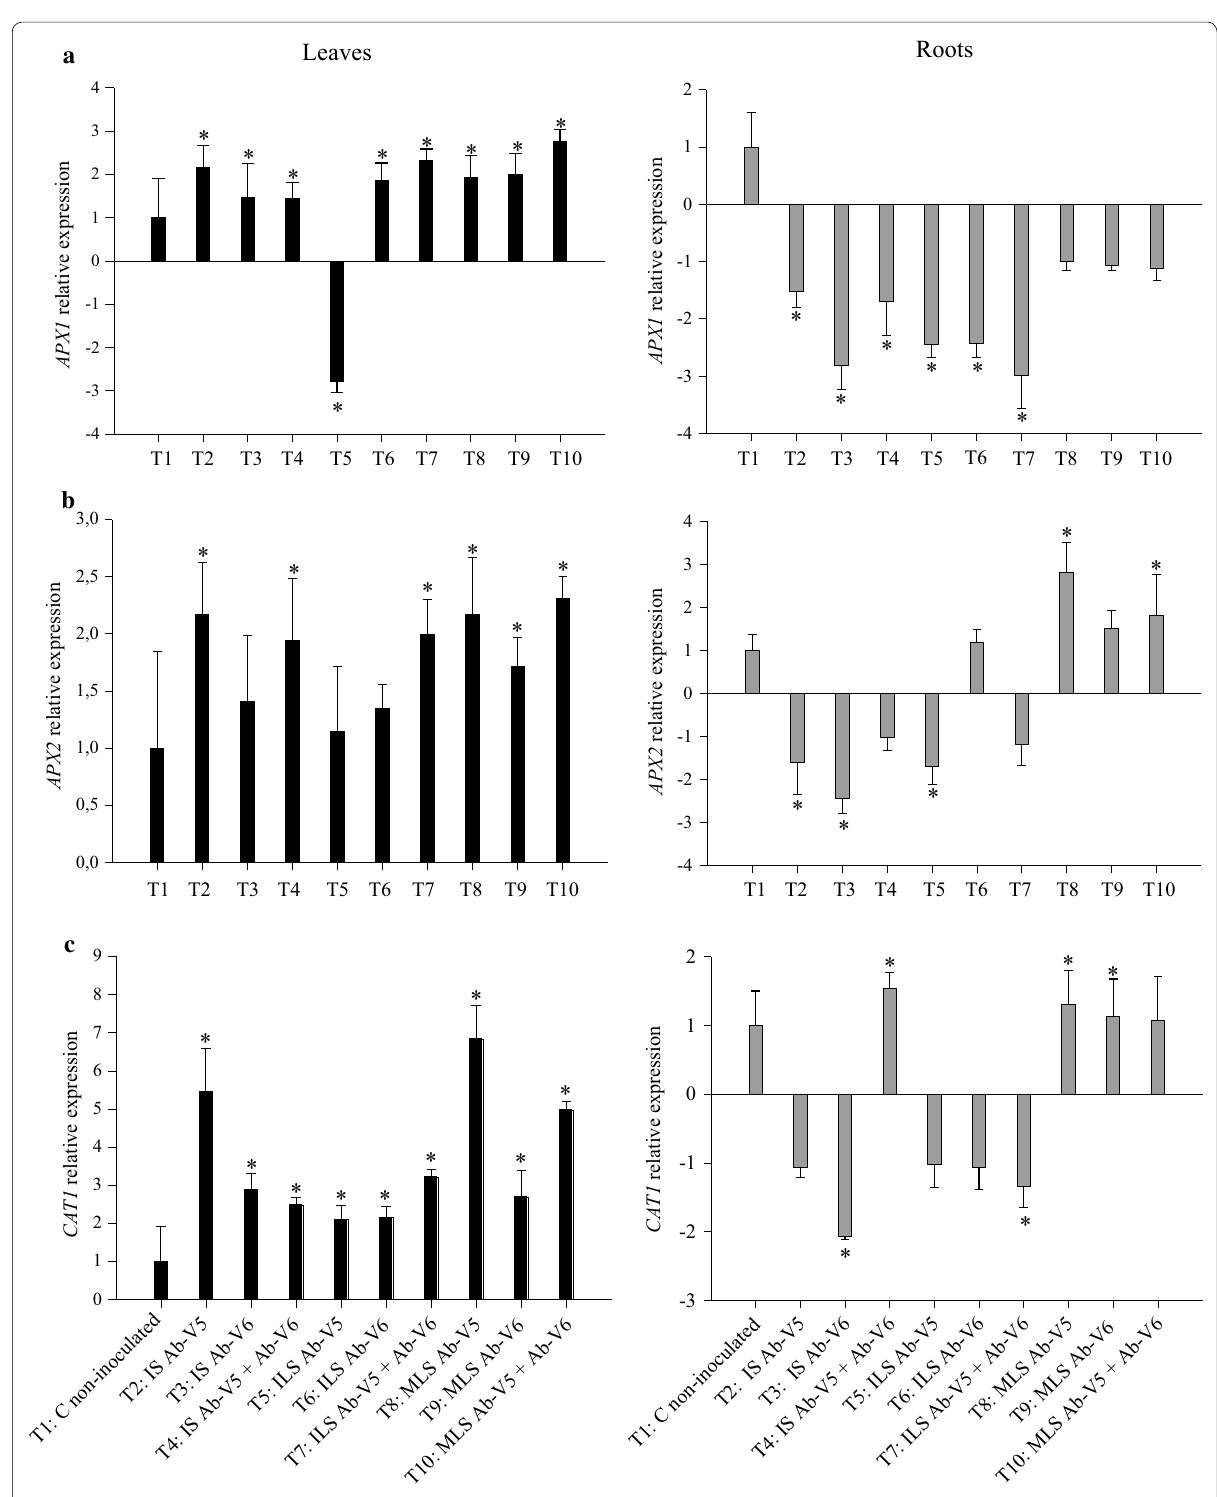
Fig. 1 RT-qPCR analysis of the expression of a APX1 , b APX2 and c CAT genes in maize leaves and roots when induced by Azospirillum brasilense strains Ab-V5 and Ab-V6 inoculated on seeds or by foliar spray, and also buy their metabolites applied by foliar spray. Data standard deviation ± from three biological replicates, each with three technical replicates. Data were normalized in relation to the endogenous control (UBCE and UBCP). The asterisks indicate statistically significant expression at the level α 5%, determined by REST2009 software. Black bars leaf and dark gray bars =